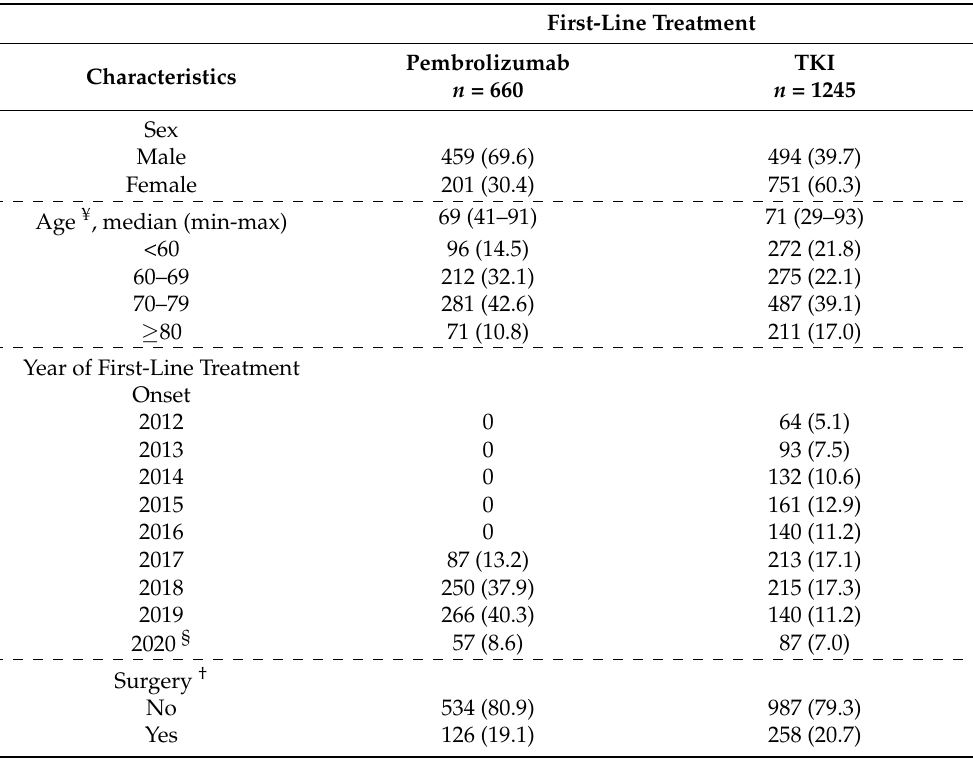
Table 1. Baseline characteristics of 660 advanced NSCLC patients treated with first-line pem- brolizumab and 1245 patients treated with first-line